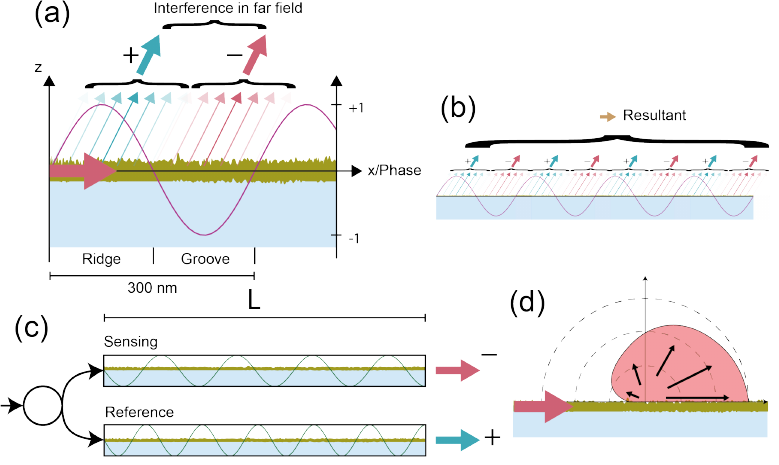
Figure 8. Diffractometric biosensors as off-angle local common path vs. refractometric interferom- eters: ( a ) diffractometric biosensors are a nearly perfectly balanced off-angle local common path interferometer. Oscillation of the phase of the electromagnetic field defines regions of construc- tive and destructive interference for a given diffraction condition. Therefore, the contribution to the resultant phasor varies sinusoidally over one grating period, whereas the edges of the ridges and grooves hardly contribute. ( b ) In the farfield, the contribution of all reference and signal re- gions is added up interferometrically to one resultant phasor. ( c ) In interferometric refractometric biosensors, the phase change is linked to different optical path lengths rather than defined by oscil- lation of the electromagnetic field. For this, the beam needs to be splitted, which introduces noise. ( d ) Scattering on the surface of a waveguide is anisotropic since the roughness power spectral density is typically Lorenzian [27]. This higher noise at lower spatial frequencies leads to predominant forward scattering and hence to worse stray light interferences in interferometric refractometric than diffractometric